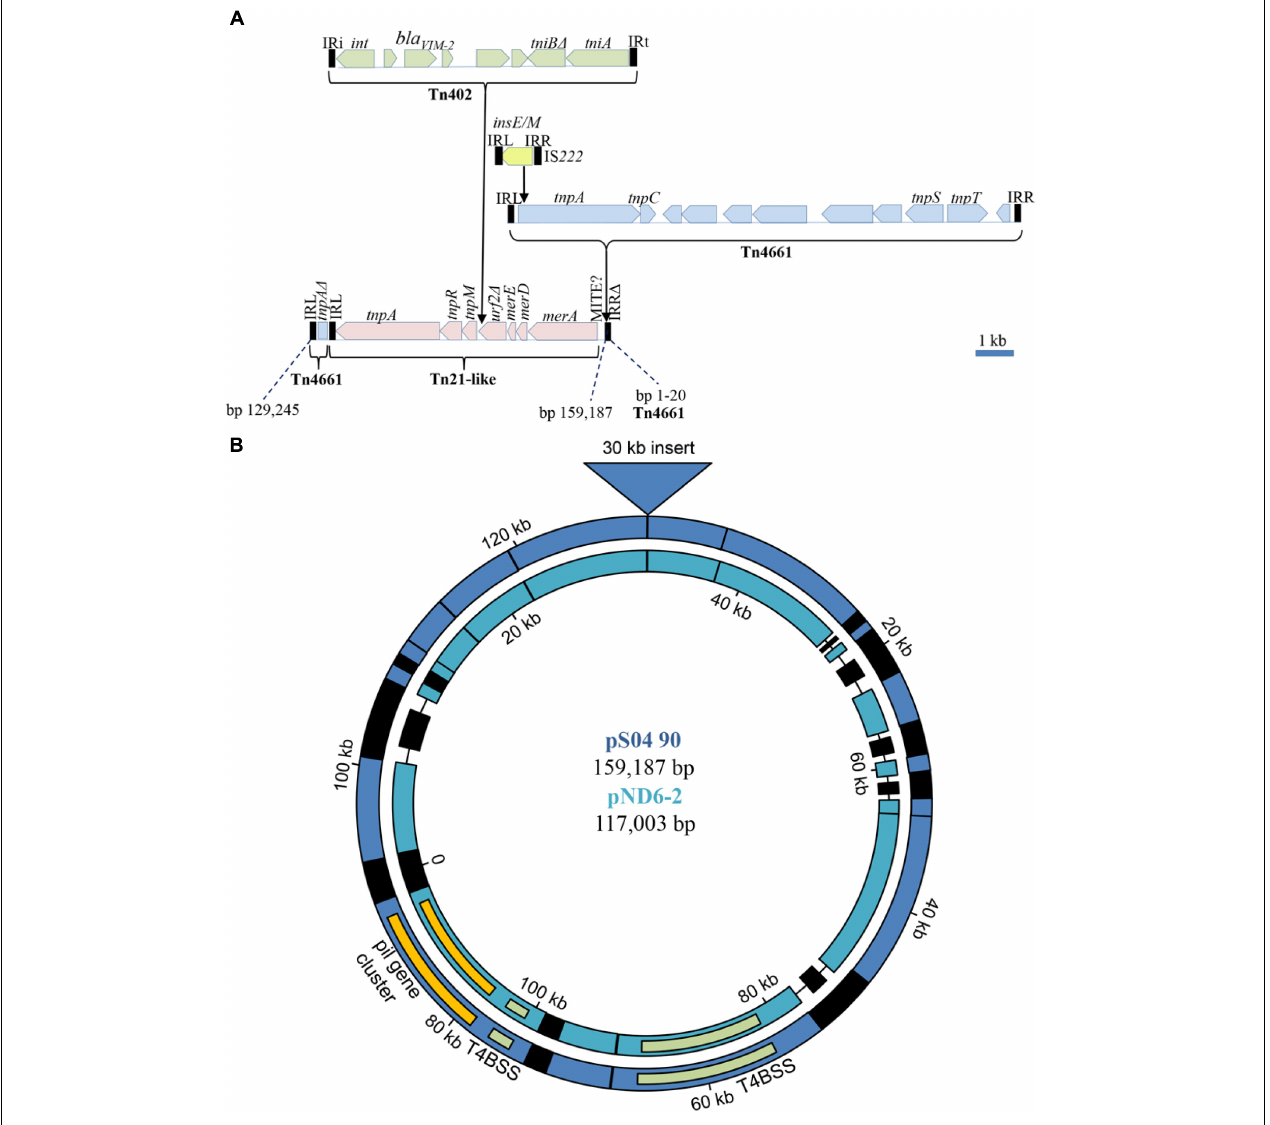
FIGURE 2 | Genetic context of the bla VIM − 2 containing integron on pS04 90. (A) Composition of a mosaic 30 kb transposon containing the integron with the bla VIM − 2 gene. Open reading frames of different transposable elements are indicated by different colors. MITE?, 332-bp inserted element possibly representing a MITE. (B) Comparison of pS04 90 (blue) with pND6-2 (sea-green). Regions of homology are indicated by color. Non-homologous regions are black and deletions are indicated by a line. The positions of the pil gene cluster (yellow) and the genes involved in the type IVB secretion system (T4BSS) (green) are indicated in both plasmids. The large insertion, detailed in (A) , is indicated by a triangle at the top. The dissimilar regions (black) around 20, 90, and 105 kb in pS04 90, encode, amongst others, a toxin/antitoxin addiction module, an O -antigen transacetylase OafA, and CRISPR-related proteins, respectively. Most of the proteins putatively encoded by the dissimilar regions are hypothetical proteins and several